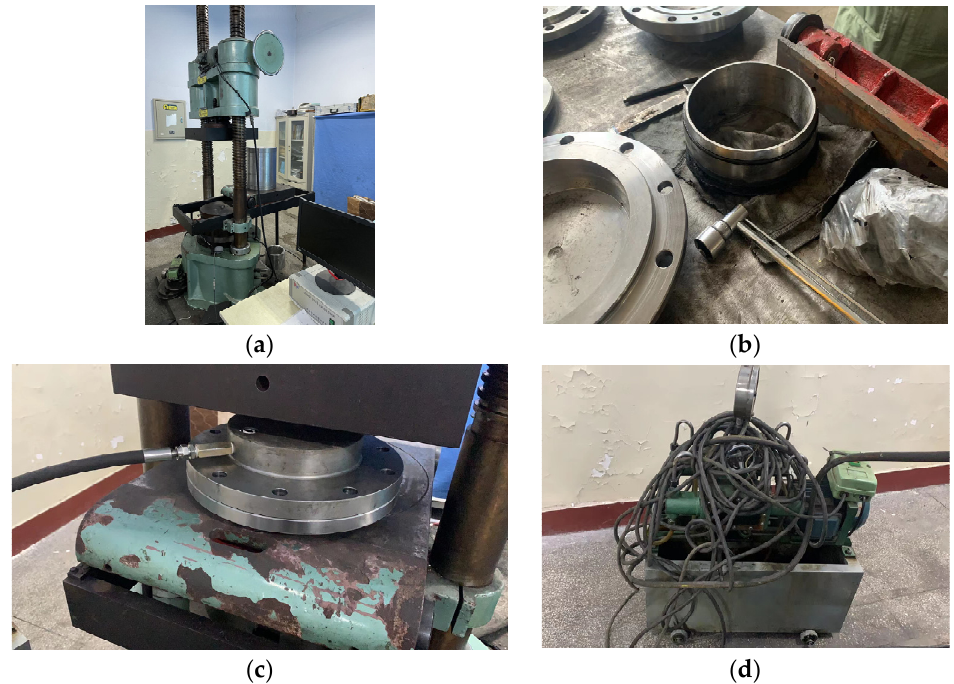
Figure 22. Object pictures of the test device. ( a ) 200 t press; ( b ) Spherical structure, flange structure; ( c ) Test device; ( d ) Hydraulic pump. ( c ) Test device; ( d ) Hydraulic